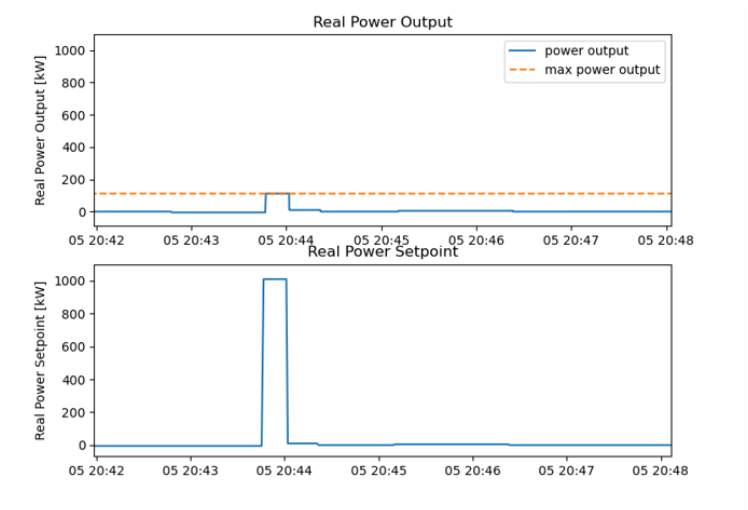
Figure 3. The real power output was set to 1010 kW, far above the 111.5 kW maximum power